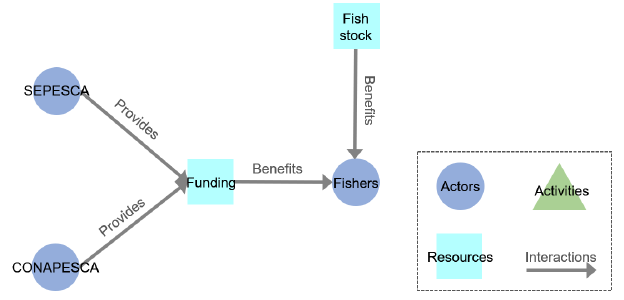
Fig. 4 . Group mental model of the representatives of nongovernmental organizations